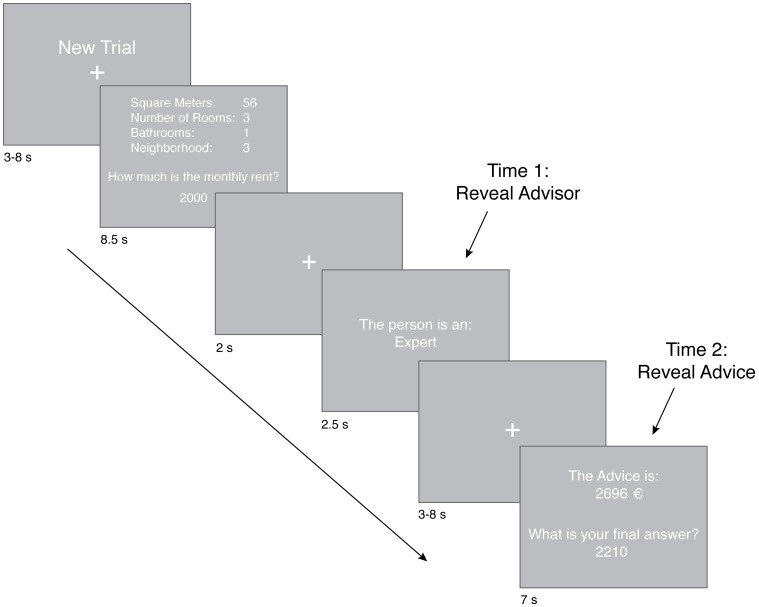
Experimental task.Participants had 8.5 s to estimate the real monthly rental price of an apartment in New York City by using four attributes (square meters, number of rooms, number of bathrooms, neighborhood). They then discovered the expertise level of their advisor (Time 1; 2.5 s). After a short delay, participants were then given advice on the rental price and allowed to adjust their answer (Time 2; 7 s).